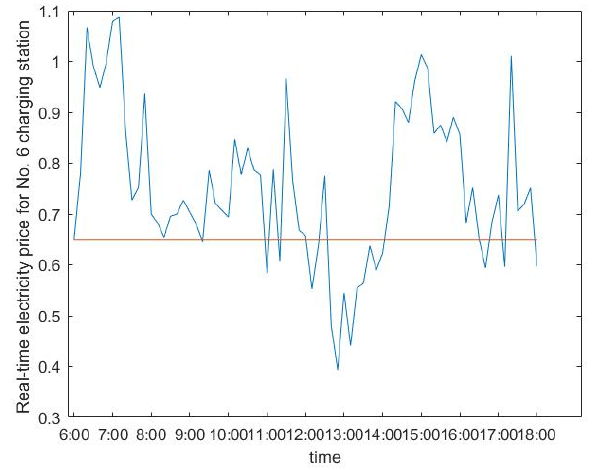
Figure 13. Real-time electricity price of the No. 6 charging station.